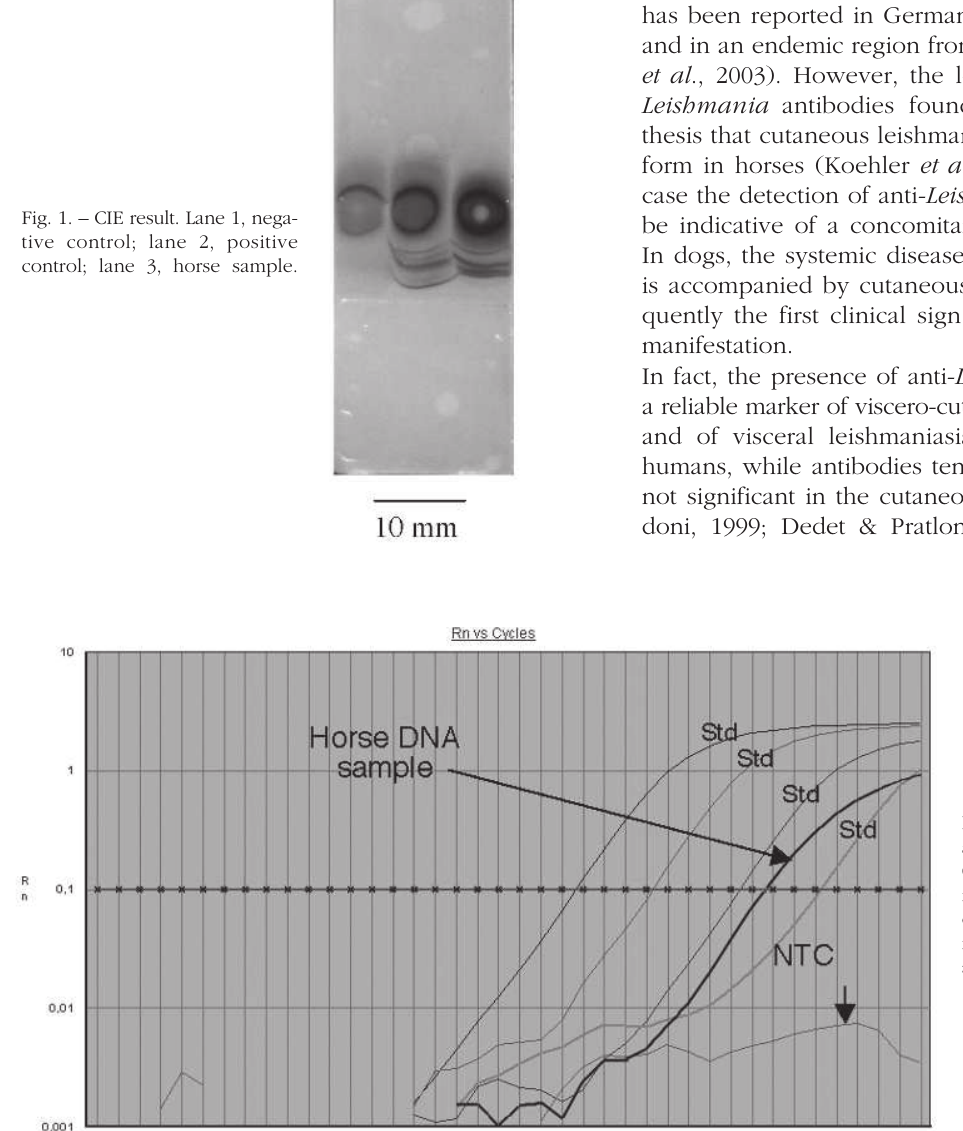
Fig. 1. – CIE result. Lane 1, nega- tive control; lane 2, positive control; lane 3, horse sample.